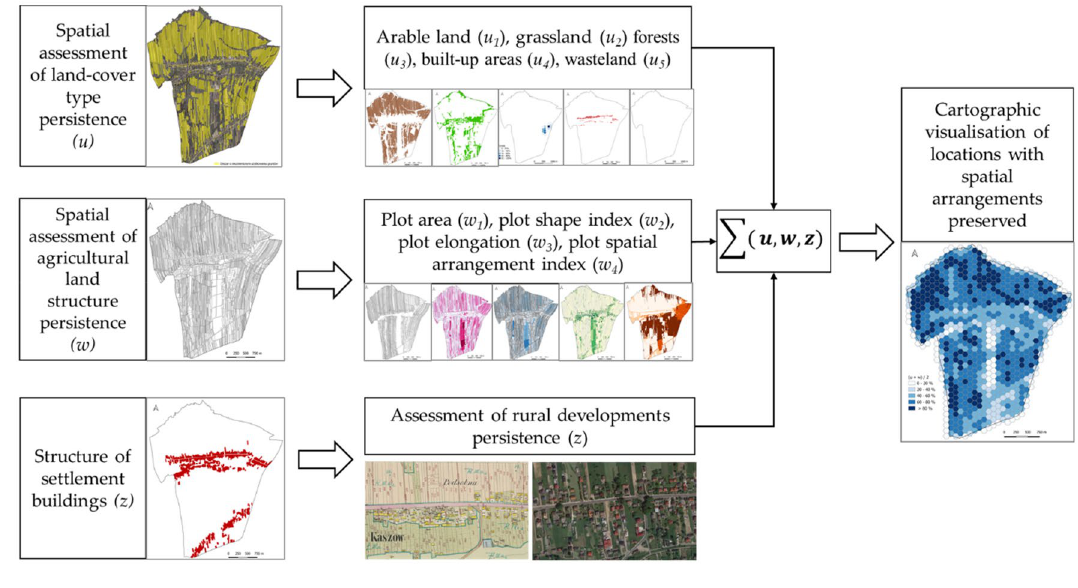
Figure 1. Research stages scheme.